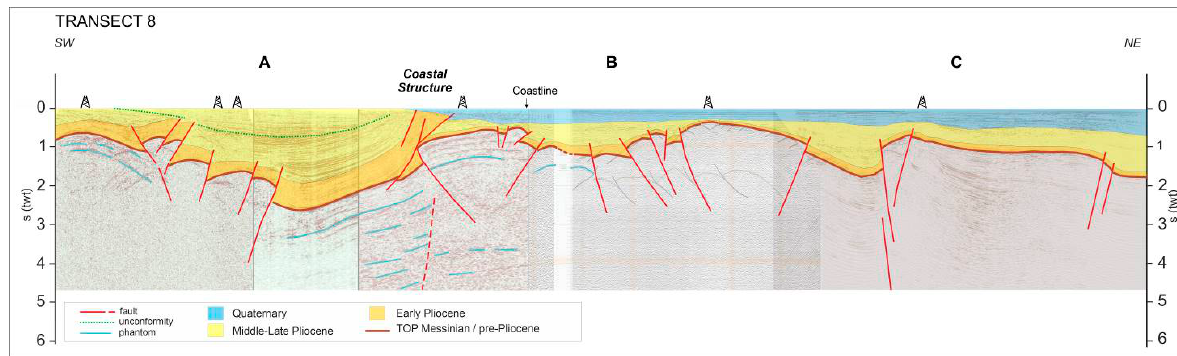
Figure 4. Transect 8. The Transect is composed of several seismic profiles labelled with letters A , B , C , see Figure 1). Quaternary deposits are highlighted in blue, Middle–Upper Pliocene deposits are in yellow, Lower Pliocene deposits are in orange, and top Messinian/Pre-Pliocene deposits are in brown. No colour is used for the pre-Pliocene sequence. Unconformities are shown in green dots. Light blue: undefined seismic reflectors. This legend is valid for all Transects (Figures 5–8).